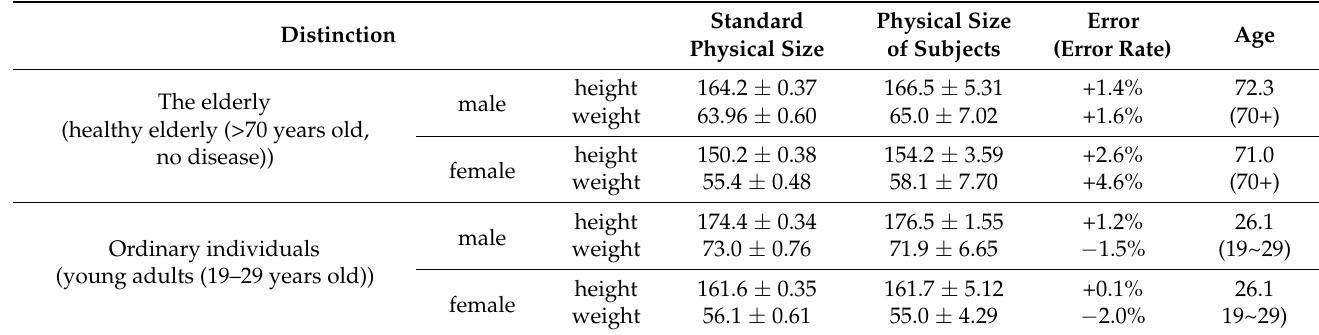
Table 2. Standard physical size and subjects’ average physical